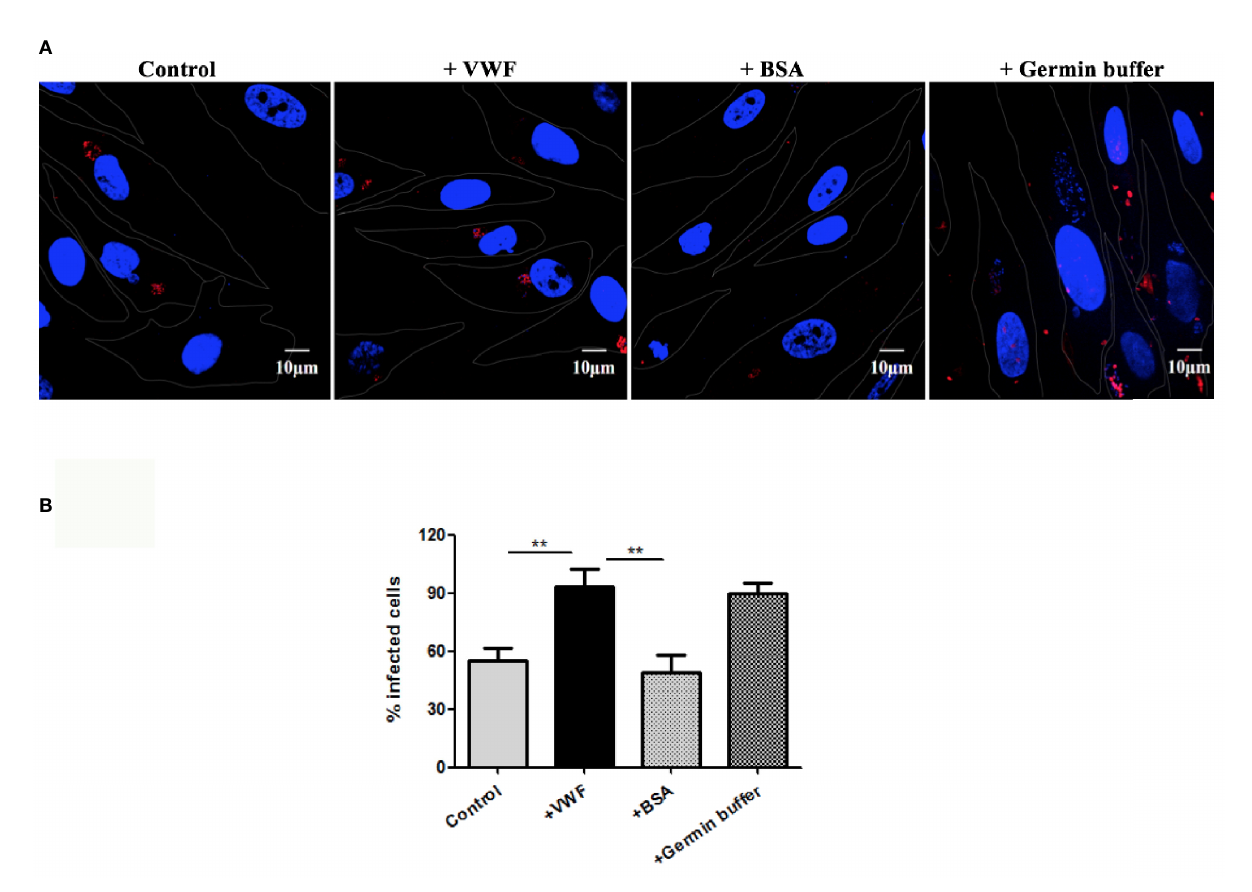
FIGURE 5 | VWF promotes E. hellem infection. (A) Representative fi elds of HFF cells exposed to E. hellem spores that had undergone no treatment (control) or binding of either FL-VWF or BSA or exposed to germination buffer. The spores were then added to HFF cells and culture for 12 h. The HFF cells outlines were depicted as ‘ dots ’ by Adobe IIIustrator CS6to the DIC images of the cells. HFF cell nuclei were stained by DAPI (blue), while the infected E. hellem was represented by FISH probe (red) (Scale bar = 10 µm). (B) Infectivity rate was the ratio of infected HFF cells over all cells, based on three independent studies with 20 random fi elds per study. The result showed that VWF treatment signi fi cantly increased the infection rate of E. hellem to host cells (F(1,59) = 2.42,**=P <0.01); while the un-related protein treatment of E. hellem spores had no effect on the infection ability (F(1,59) = 1.92, **P <0.01).